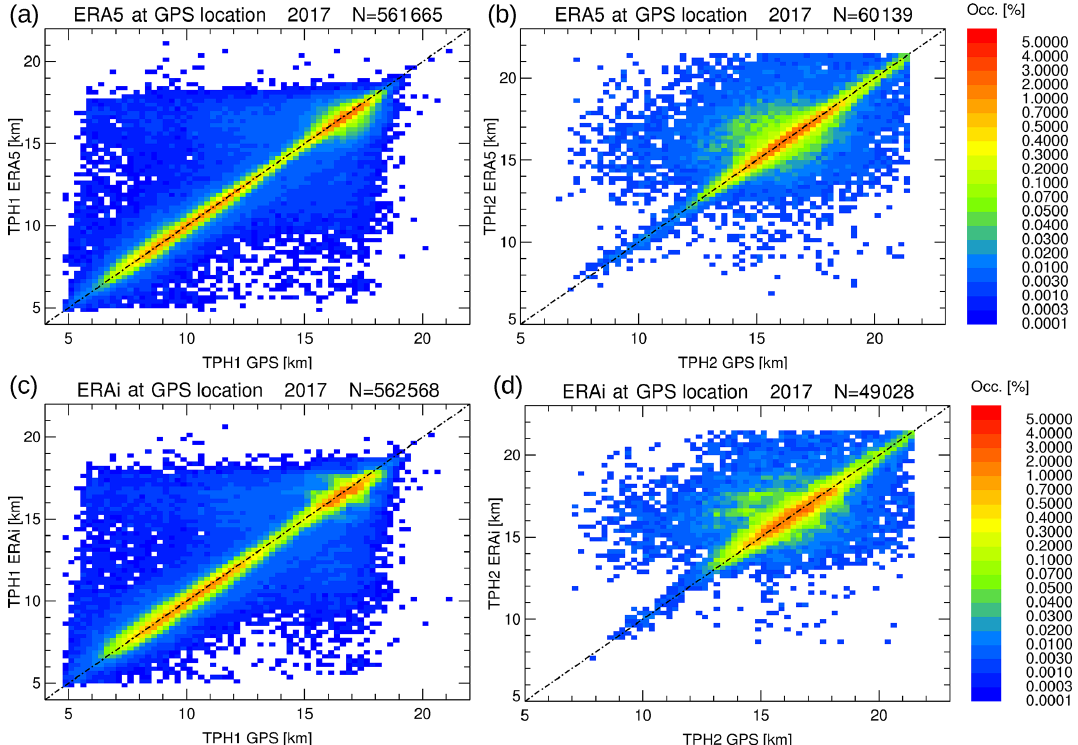
Figure 19. Probability density functions of first (a, c) and second (b, d) tropopause heights from GPS versus ERA5 (a, b) and ERA- Interim (c, d) for all COSMIC profiles in 2017. The bin size is 200m × 200m. Note the log-like intervals of the color bar. For details see